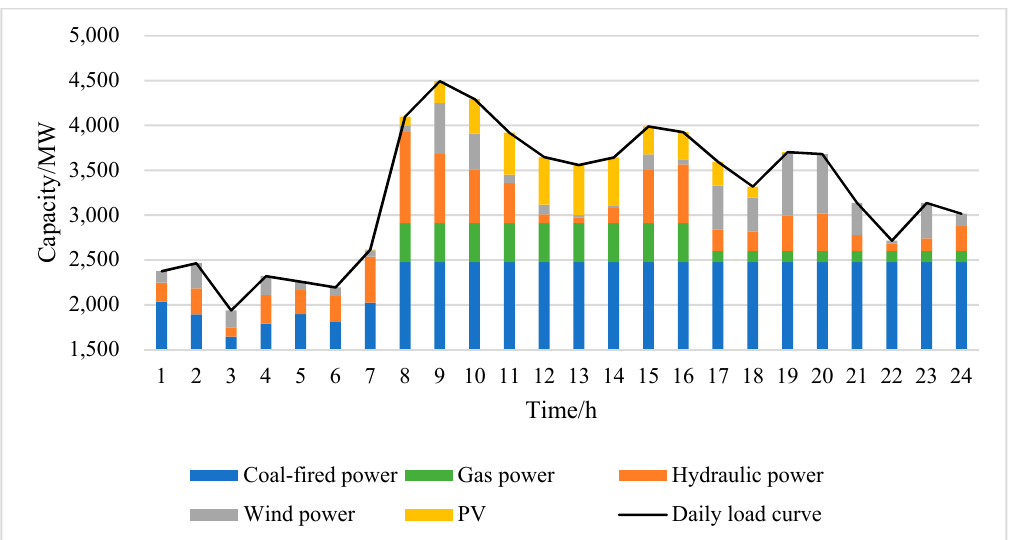
Figure 4. Energy output diagram of each type on a typical day.